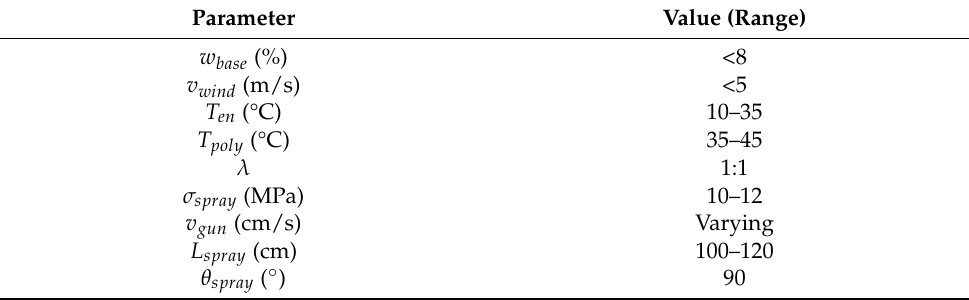
Table 6. Recommended range of spraying process